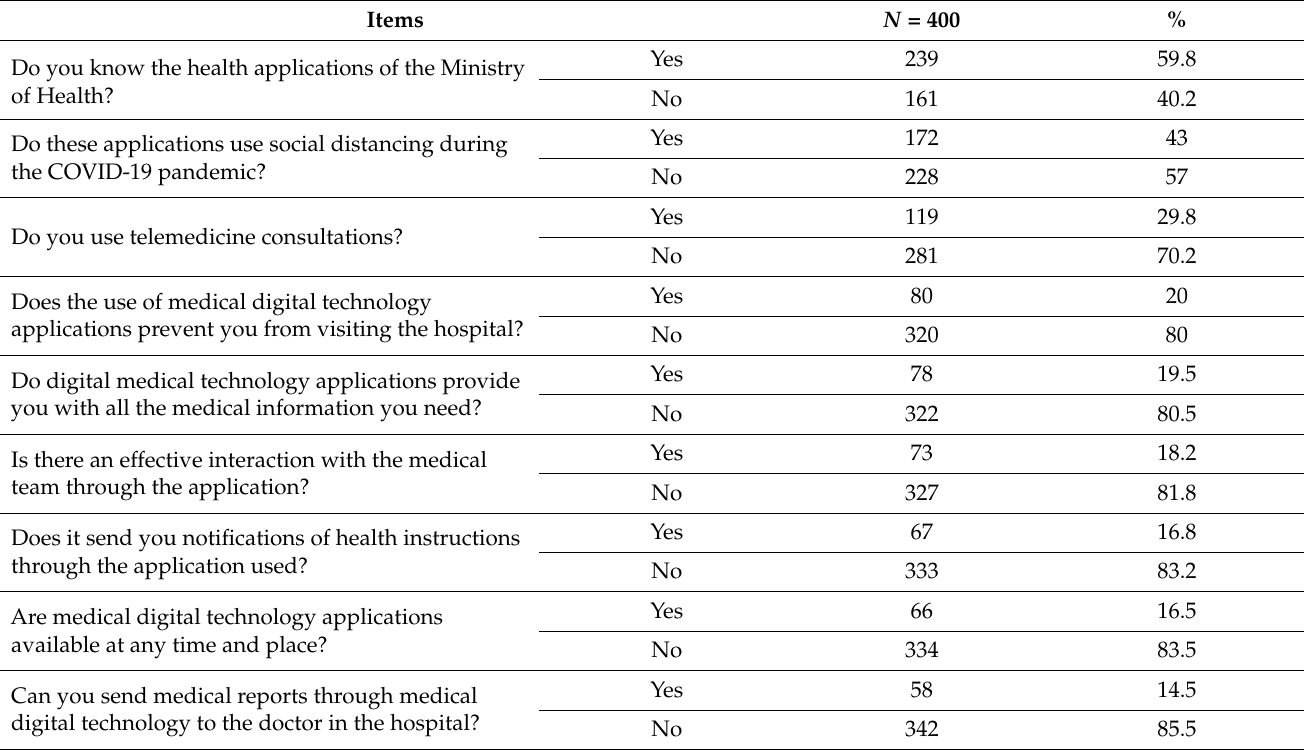
Table 4. Data about applications of medical digital technologies for patients in the study during the COVID-19 pandemic.